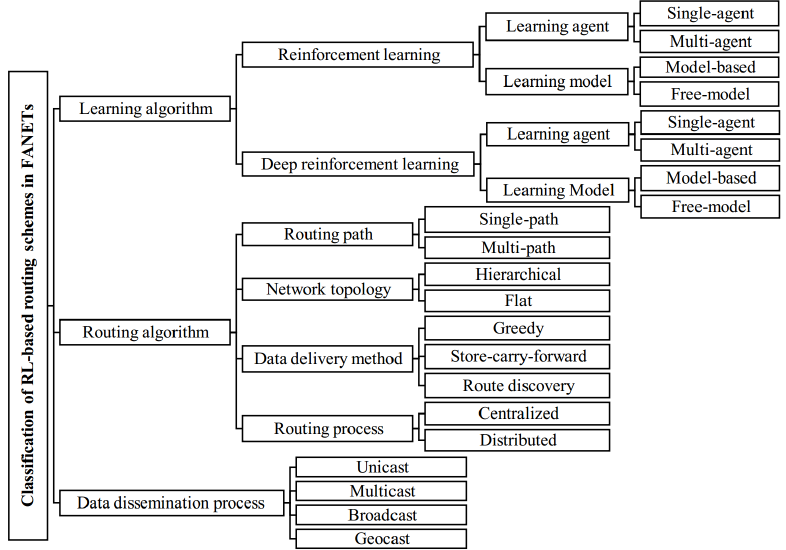
Figure 6. Classification of reinforcement learning-based routing protocols.